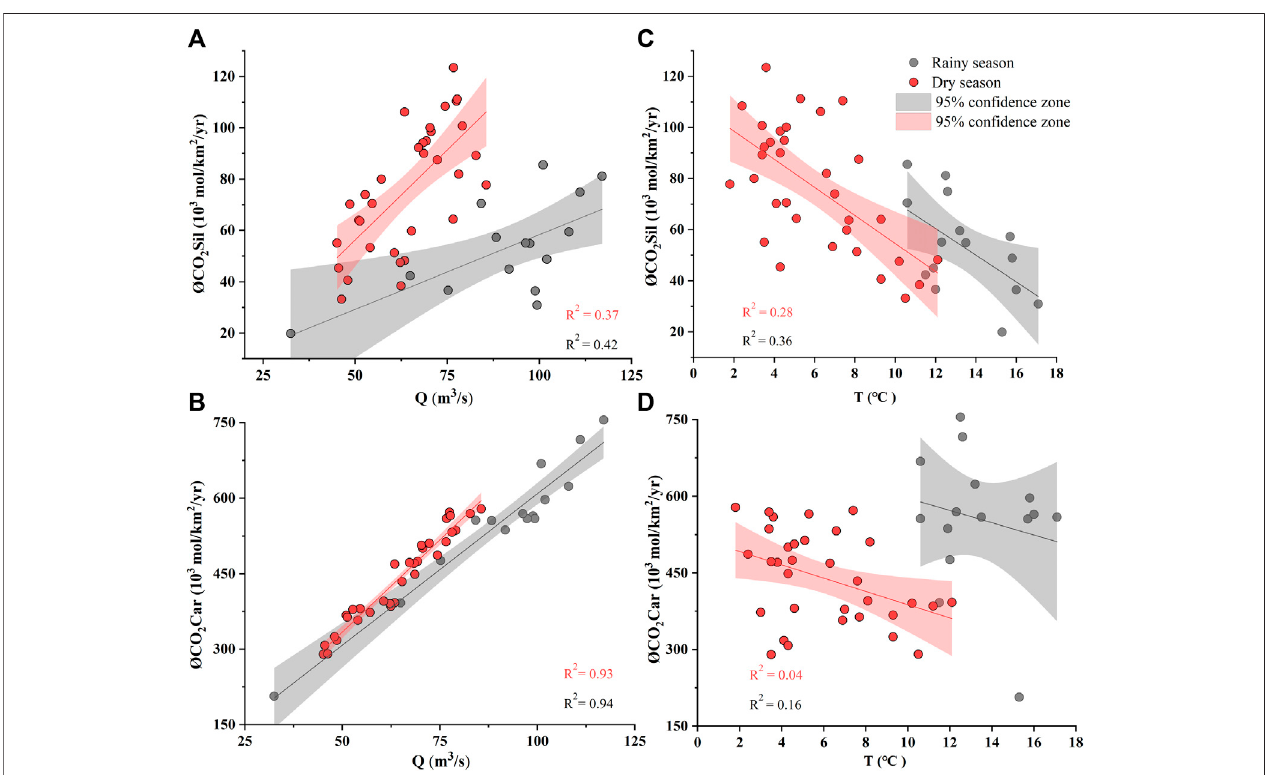
FIGURE 9 | Relationships between the CO 2 consumption rate (ØCO 2 ) and discharge and water temperature. Signi fi cant correlations are observed between ØCO 2car and Q, indicating a critical runoff control on carbonate weathering. No clear correlations are observed between ØCO 2 and temperature.